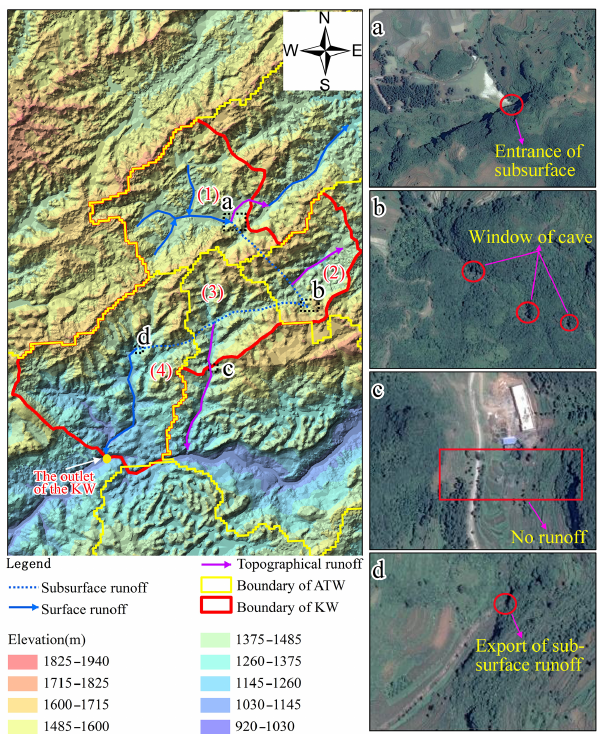
Figure 4. Correction divide based on the auto-delineating topo- graphic watersheds (ATW) boundary in the depression area. KW represents “karst